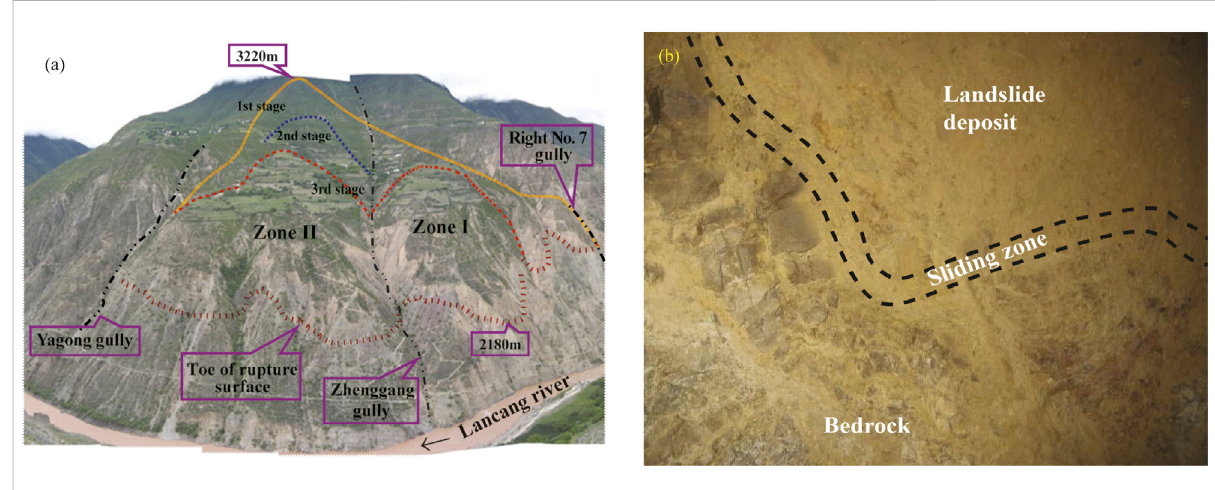
FIGURE 4 Aerial view and geomorphic features of the Zhenggang landslide (Xu 2010).p